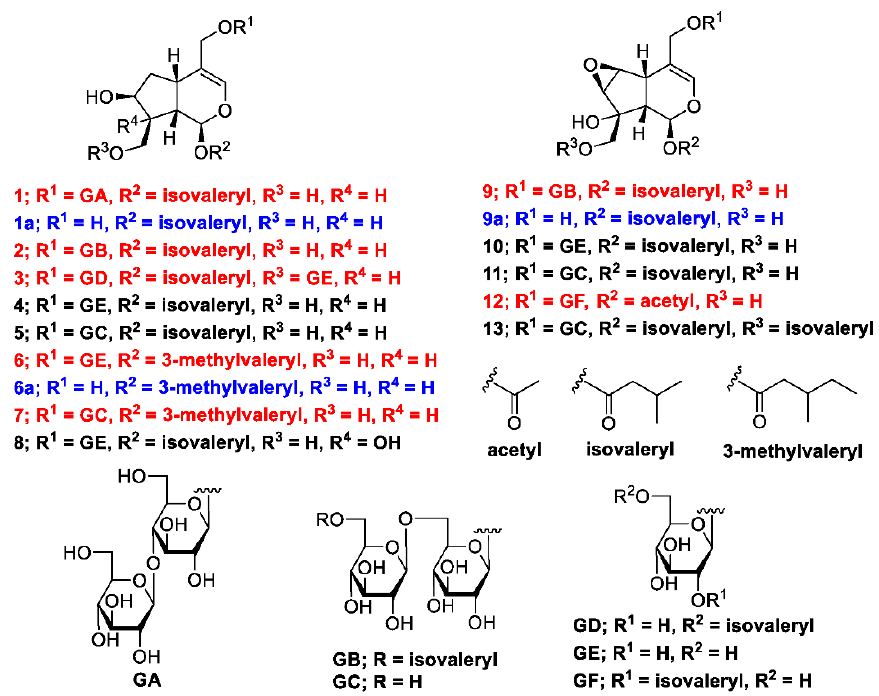
Figure 1. Chemical structures of constituents 1 – 13 isolated from V. fauriei and their derivatives 1a , 6a , and 9a .